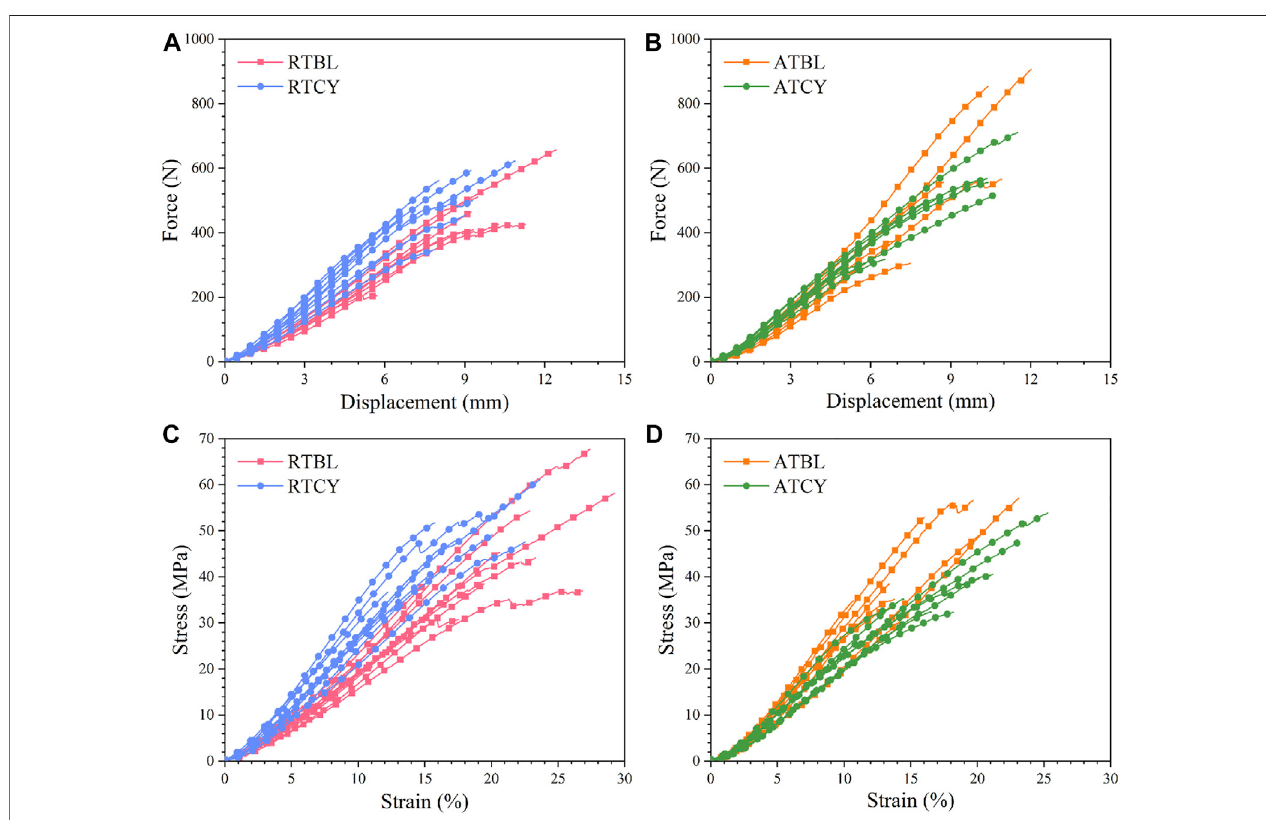
FIGURE 4 | Tensile curves as a function of cyclic loading at two different temperatures. Force-displacement curves: (A) At room temperature (n = 9); (B) At intra- articular temperature (n = 8). Stress-strain curves: (C) At room temperature (n = 9); (D) At intra-articular temperature (n = 8). The curves end at their respective failure points. At room temperature, the average stiffness and modulus ofthe samples after 240 cycles ofcyclic loading (i.e., RTCY) were higher than those ofthe samplesonly went through 10 cycles of cyclic loading (i.e., RTBL). At intra-articular temperature, the samples after 240 cycles of cyclic loading (i.e., ATCY) generally had lower stiffness and modulus than those after 10 cycles of cyclic loading (i.e.,